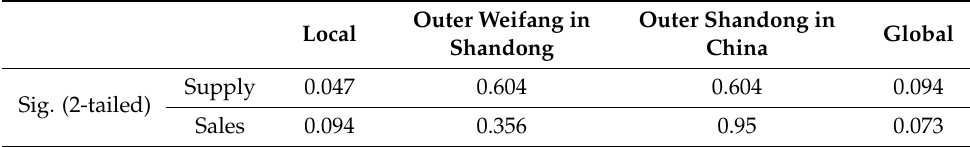
Table 7. Sig. (2-tailed) of paired sample t -test of firms’ logistics linkages at different geographical scales during the